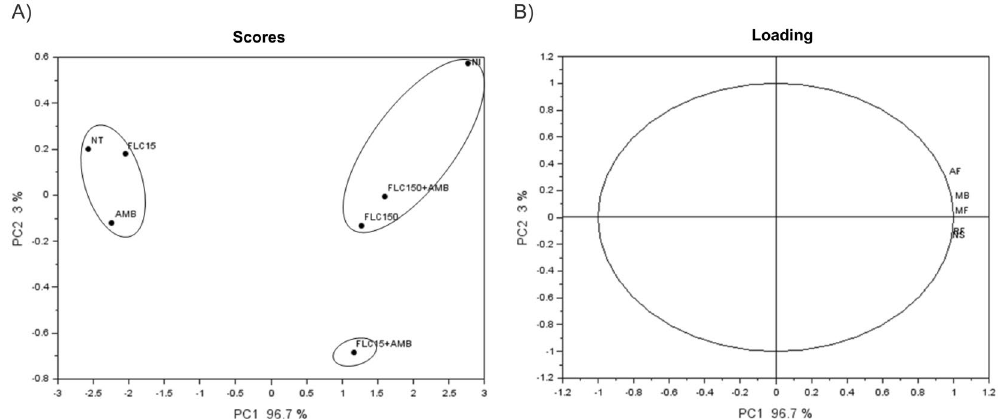
Figure 4. Graphic representation of the scores ( A ) and loadings ( B ) of the analyzes performed on the animals of the groups. NI (not infected); NT (Control, untreated), AMB (Amphotericin B 0.5 mg/kg/day), FLC15 (Fluconazole 15 mg/kg/day), FLC150 (Fluconazole 150 mg/kg/day) FLC15 + AMB (Fluconazole 15 mg/kg/ day + Amphotericin B 0.5 mg/kg/day), FLC150 + AMB (Fluconazole 150 mg/kg/day + Amphotericin B 0.5 mg/ kg/day) at the end of 42 days of treatment, evaluated in relation to the axes defined by the main components (PC1 and PC2). NS: neuropsychiatric state, MB: motor behavior, AF: autonomic function, MF: muscle tone and strength, and RF: reflex and sensory function.